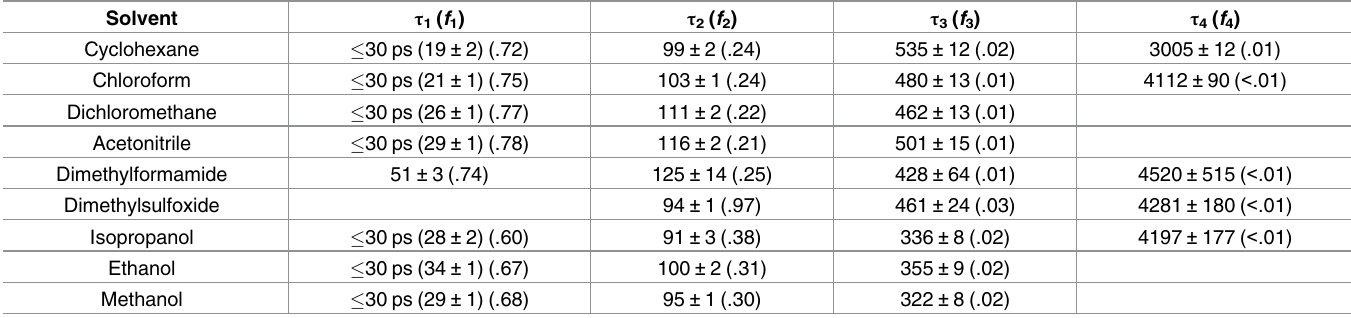
Table 7. Fluorescence decay of the K2T23 enol